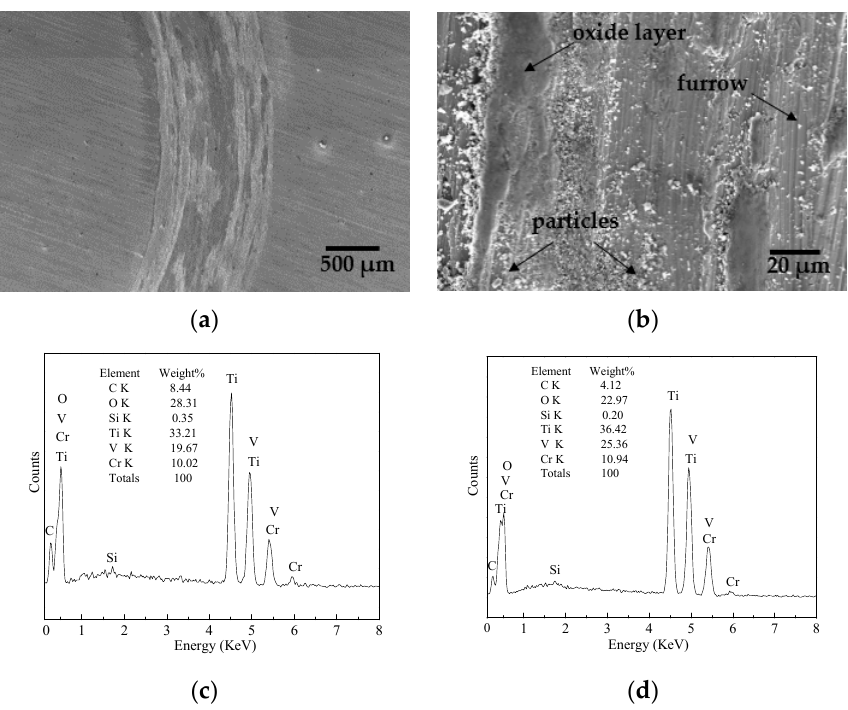
Figure 8. SEM morphologies and EDS spot ‐ analyses of the worn surface in TF550 alloy after wearing at 873 K. ( a ) Low magnification SEI; ( b ) high magnification SEI; ( c ) compositions of the oxide layer region; and ( d ) compositions of the particles region.